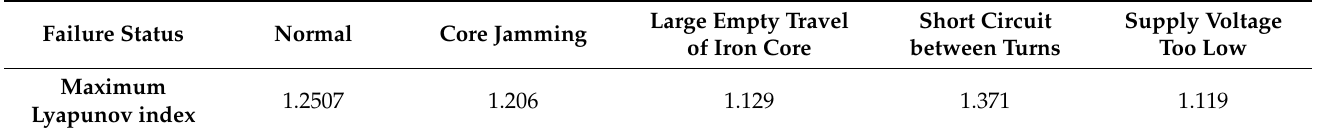
Figure 2. Normal state multi-cycle current signal with corresponding Lyapunov exponential spec- trum: ( a ) multi-cycle current signal; ( b ) Lyapunov index spectrum. Table 1. Maximum Lyapunov index for different fault